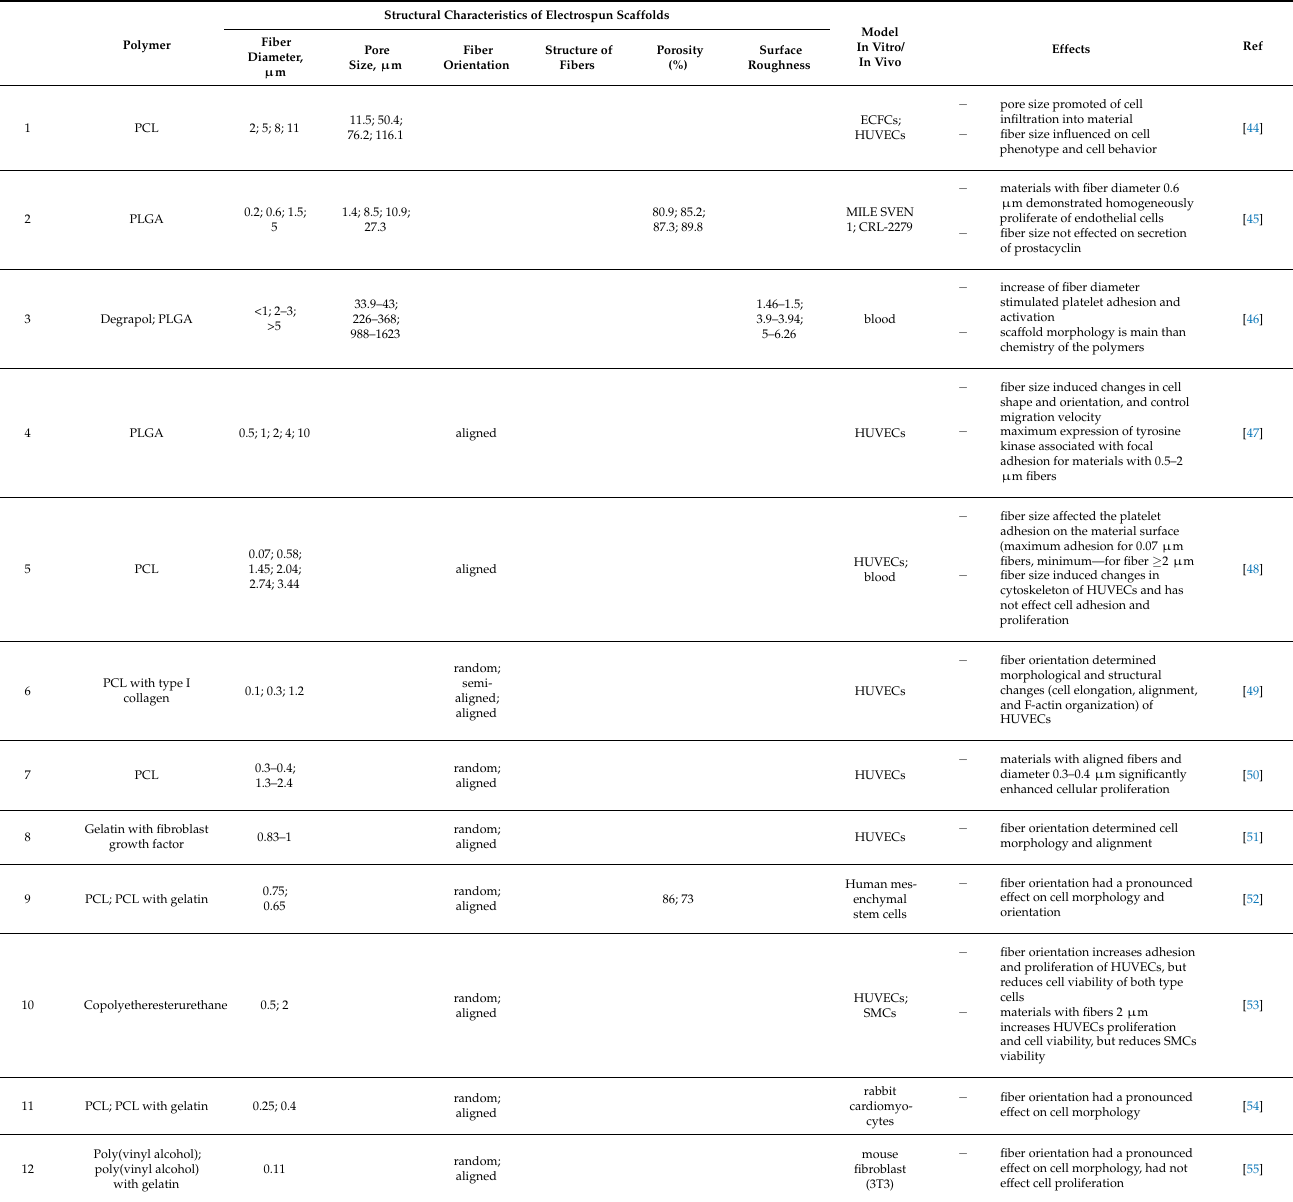
Table 1. Characteristics of electrospun scaffolds and cell-to-matrix interaction in vitro/in